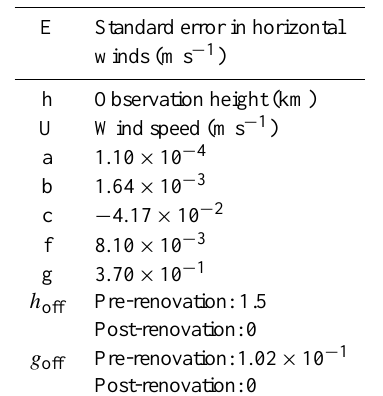
Table A1. Variables and constants used to approximate the random error in NERC MST radar horizontal winds with Eqs.